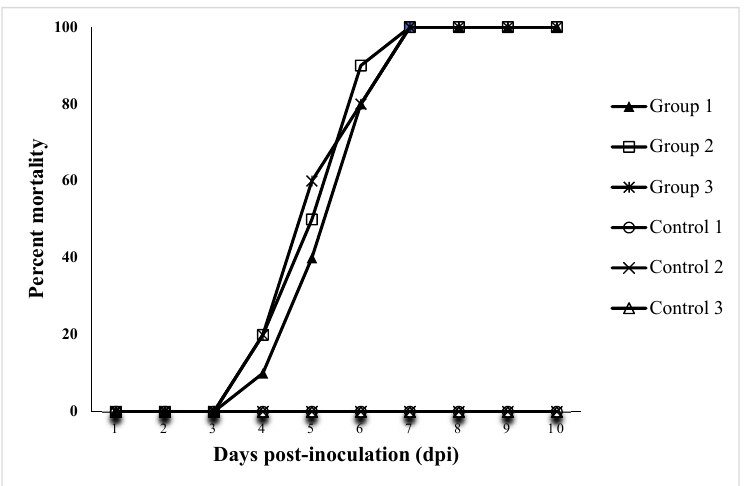
Figure 5. Cumulative mortality curves of the experimentally infected M. rosenbergii with strain GDZQ201912. Controls 1, 2, 3, and three replicates of healthy prawns injected with PBS; Groups 1, 2, 3, and three replicates of healthy prawns injected with bacterial inoculum. Each trial contained 10 animals.